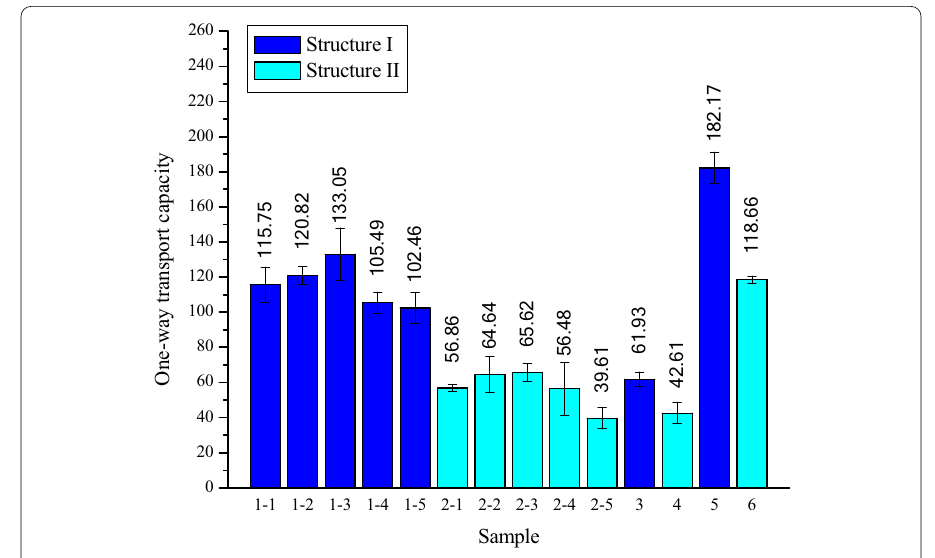
Fig. 4 The results of one-way transport capacity by MMT